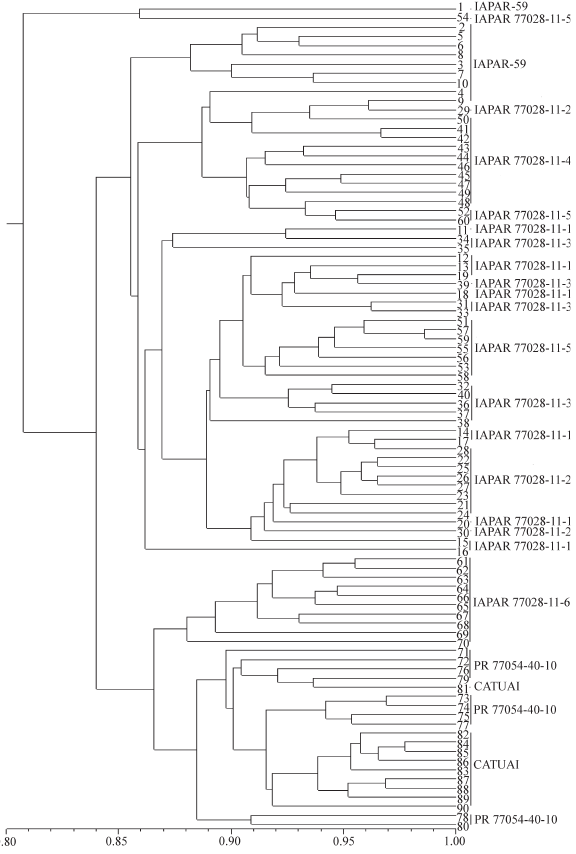
Figure 4 - Genetic relationships obtained among plants of progenies and cultivars of C. arabica on the basis of Dice’s similarity coefficient.